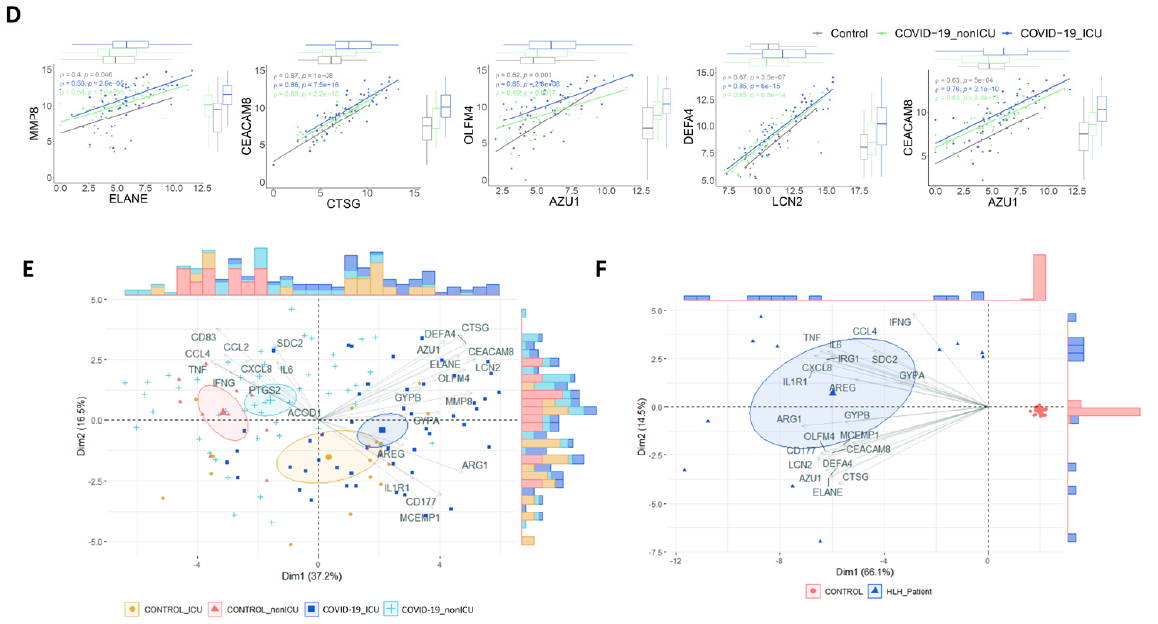
Figure 4. Transcripts stratifying severe COVID-19 from other respiratory diseases and HLH from healthy controls. ( A ) Schematic overview of study design and patient classification of dataset GSE157103 reported by Overmyer et al. [26]. Created with BioRender.com. ( B ) Protein-protein interaction (PPI) network highlighting interactions among the 158 proteins and the 25 genes significant for severe COVID-19_ICU, while keeping their other interacting partners ( n = 9921) in the middle circle. The node colour denotes Gene Ontology Biological Process terms. The left circle shows 123 proteins and 554 interactions, the upper right half circle shows 21 proteins and 29 interactions, and the lower right side half circle shows 25 proteins and 65 interactions. Molecules involved in neutrophil-mediated immunity are highlighted with a blue node outline. ( C ) Correlation matrices of the 25 DEGs in controls and COVID-19 groups (Controls, left matrix; COVID-19_nonICU, middle matrix; and COVID-19_ICU, right matrix). The color scale bar represents the Pearson’s correlation coefficient, containing negative and positive correlations from − 1 to 1, respectively. ( D ) Scatter plots with marginal boxplots display the relationship between the eight genes stratifying severe COVID-19. Correlation coefficient ( ρ ) and significance level ( p -value) for each correlation is shown within each graph. ( E ) Principal Component Analysis (PCA) with spectral decomposition shows the stratification of COVID-19_ICU from COVID-19_nonICU and other respiratory diseases (Control_nonICU and Control_ICU). Variables with positive correlation are pointing to the same side of the plot, contrasting with negative correlated variables, which point to opposite sides. Confidence ellipses are shown for each group/category. Bar plots associated with the PCA represent the sample distribution across the PCA axes. ( F ) PCA displaying the stratification of HLH patients and healthy controls is based on the same 25 DEGs as in ( E